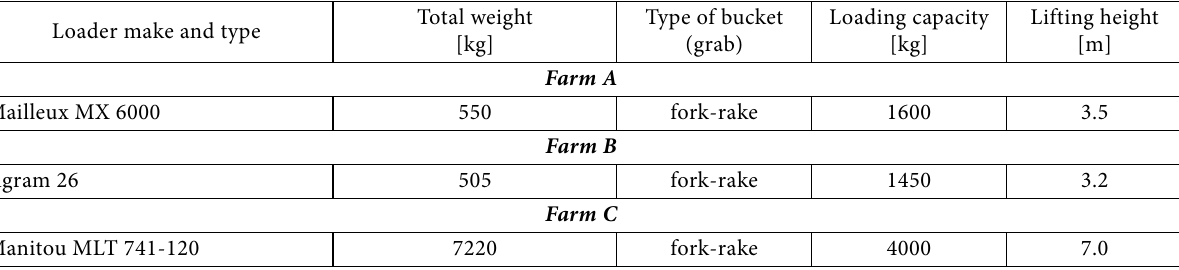
Table 2. Abbreviated technical characteristics of loaders